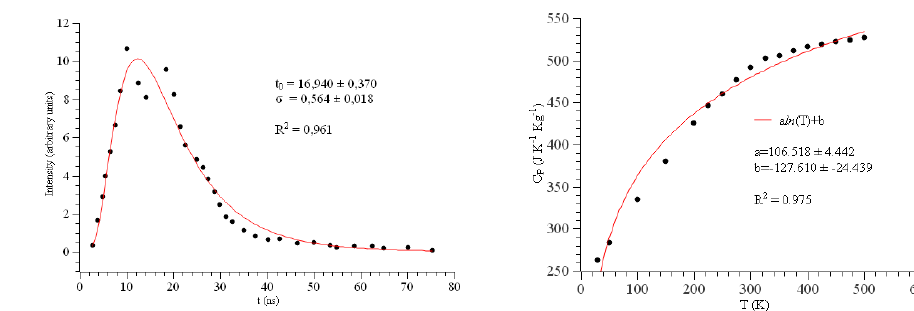
Figure 3. Fitting of the laser profile with a lognormal dependence on time. t 0 is related to the instant at which I ( t ) is maximum and σ is the standard deviation. R 2 is the statistical measure of goodness of fit.